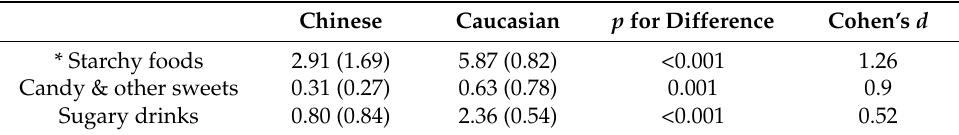
Table 3 Showing average daily sugary, starchy food consumption between groups. Values are mean ± (SD) Standard Deviation. p value for difference calculated by independent samples t -test. Effect size was calculated by Cohen’s d .